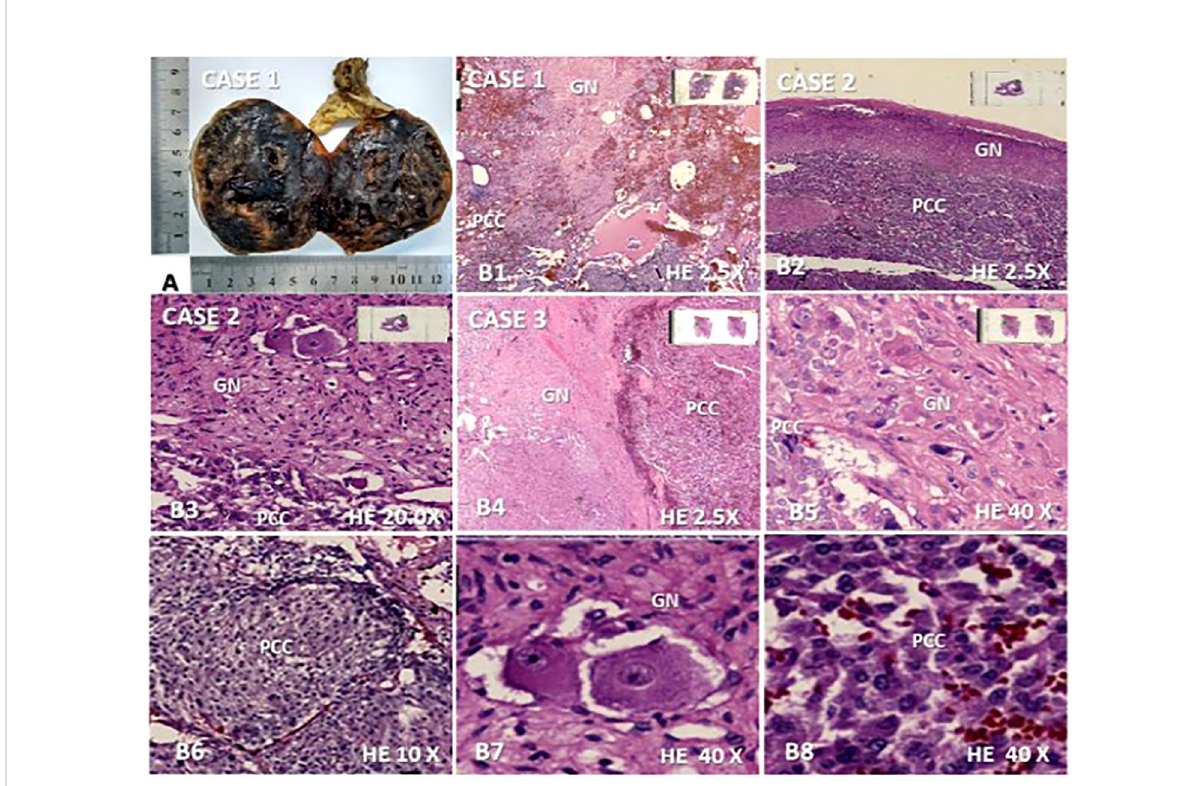
FIGURE 1 Macroscopic and microscopic features found in the three composite pheochromocytoma (CP) cases with ganglioneuroma as a neurogenic component. (A) Opened surgical specimen of case 1 measuring 7.0 ×6,0 × 6.0 cm; (B1 – B8) , microscopy (hematoxylin-eosin) revealing the presence of both components of CP in cases 1, 2 and 3: (B1) . ganglioneuroma (GN) interspersed between pheochromocytoma (PCC) and cystic/hemorrhagic areas (2.5×); (B2) . ganglioneuroma presenting as a peripheral ridge adjacent to the chromatin tumor in case 2 (2.5×); (B3) . GN dispersed in most part of the fi gure with clear margin of frontier with PC component located in inferior region (20×); (B4 , B5) . well- delimited neurogenic component of the CP of the case 3 is shown on the left side (B4) (2.5×) and in most part of the fi gure (B5) (40×) while PCC is seen, on the right side (B4) (2.5) and in the left inferior region (B5) (40×); (B6) . A nodular area of PC is represented (10×); (B7) . Ganglion cells dispersed in Schwan stroma; (B8) . Chromaf fi n cells network of